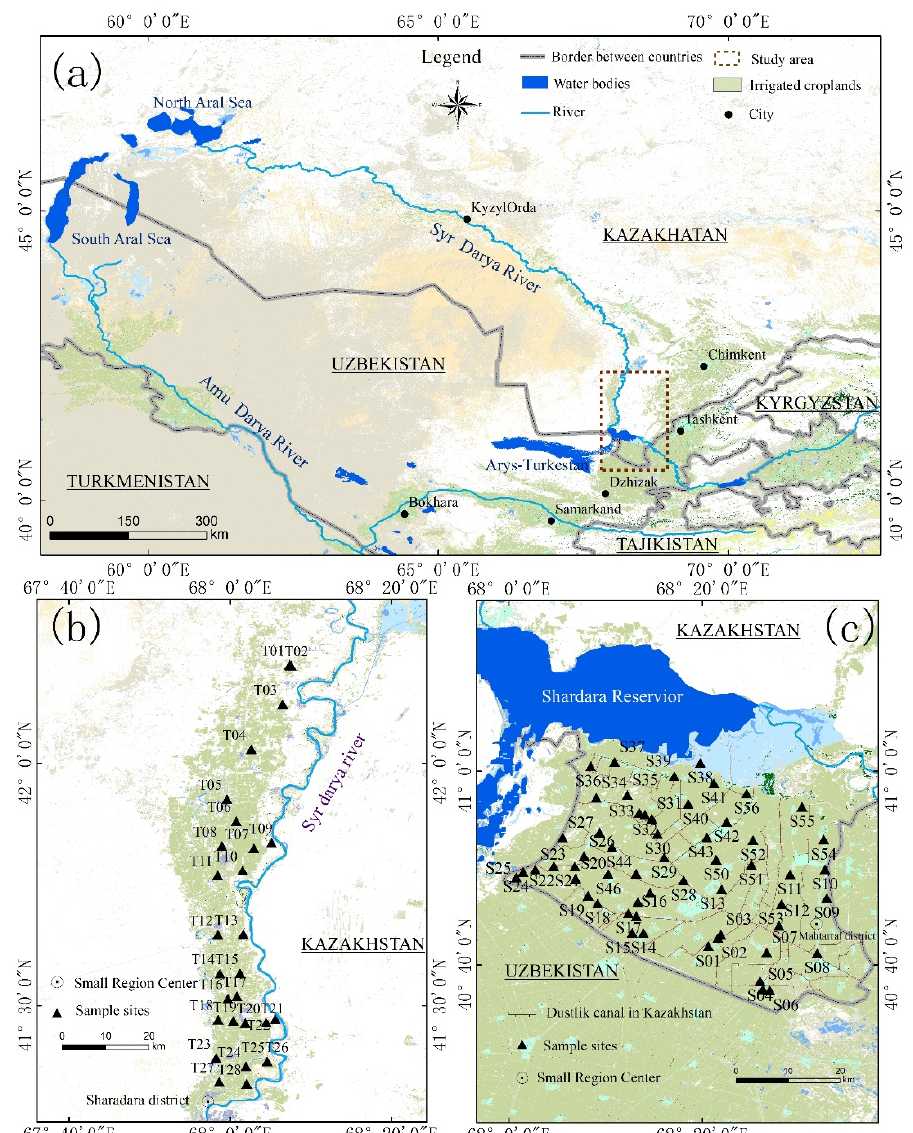
Figure 1. ( a ) Study area in Kazakhstan. ( b ) Location of sampling sites in Shardara (T01–T28). ( c ) Location of sampling sites in Mahtaaral (S01–S56).